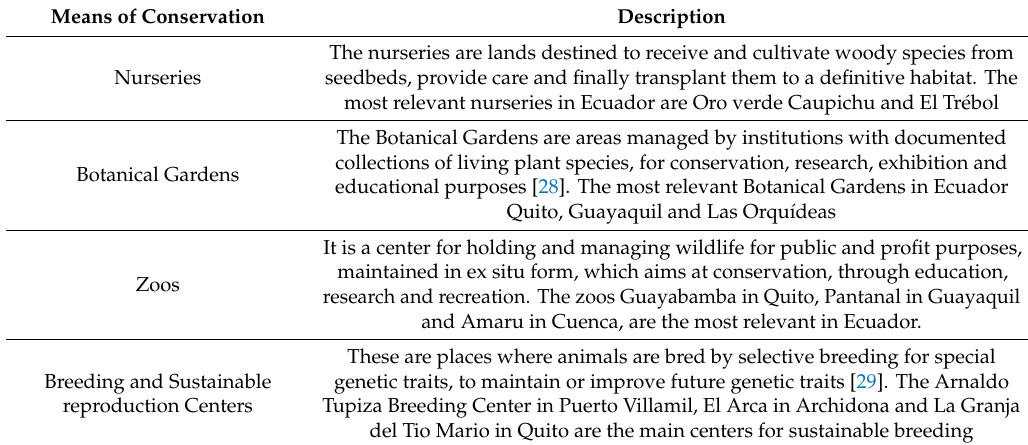
Table 6. The major ex-situ conservation strategies for biodiversity conservation in Ecuador